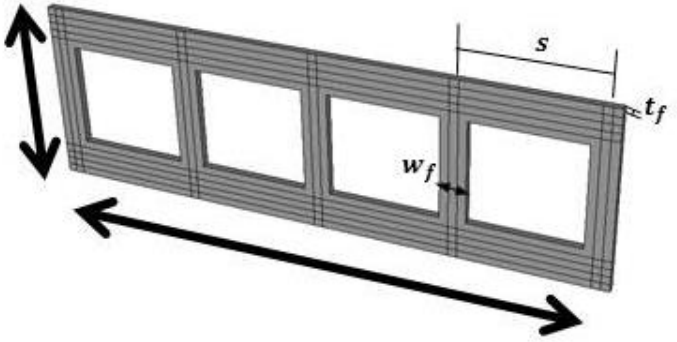
Figure 1. The component of the glass fiber reinforced polymer (GFRP) vertical